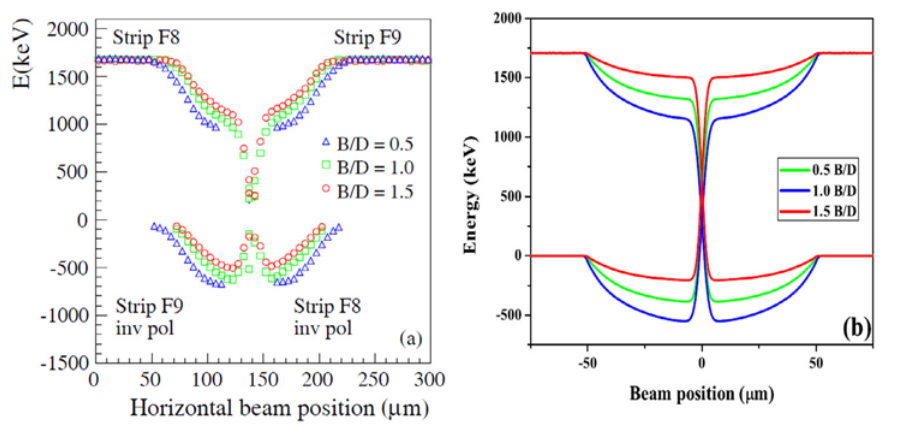
Figure 2: Energy as function of position for proton of 1.7 MeV for three different bias voltages. On the left panel are shown experimental data refering to a front interstrip region, on the right panel are shown data coming from simulations (fro more information see the text). B/D indicates the ratio between the applied bias and the full depletion